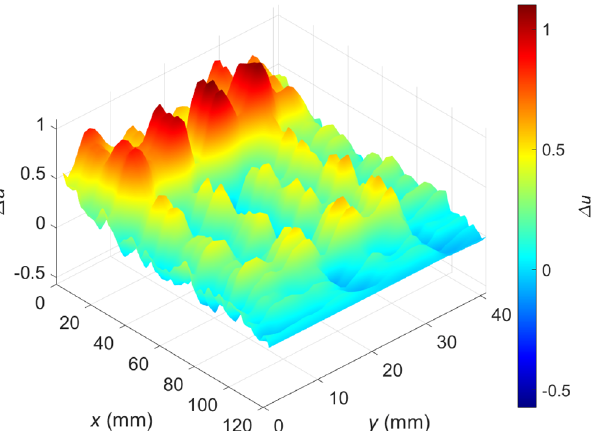
Figure 9. Two-dimensional plot of the relative voltage as a function of the sensor position; excitation frequency f = 2 MHz; a raw signal before background removal.